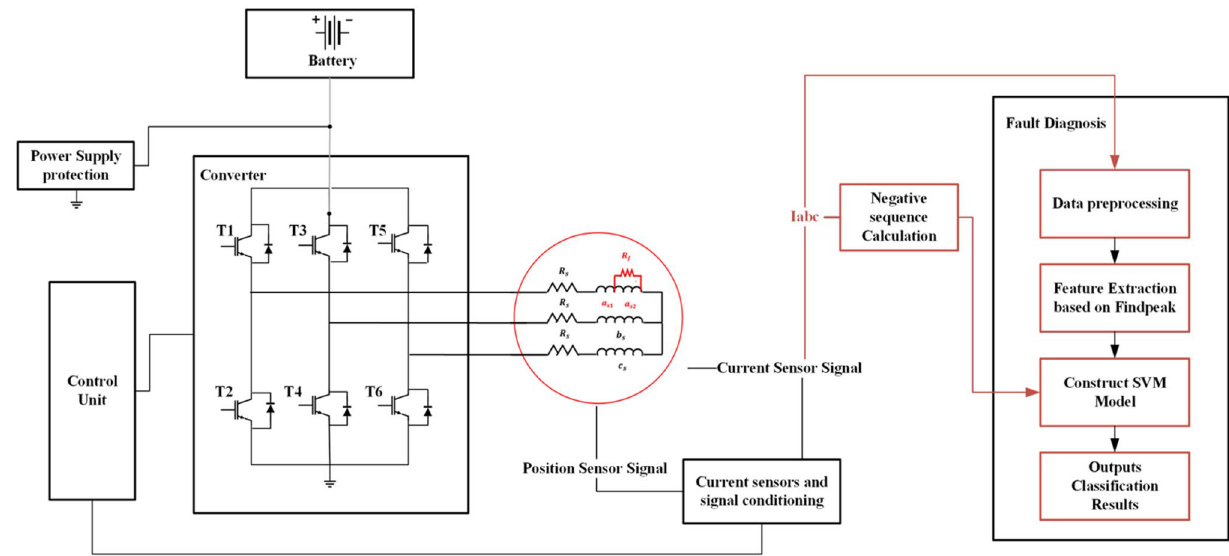
Fig. 2 Inter-Turn Stator Winding Fault diagnosis